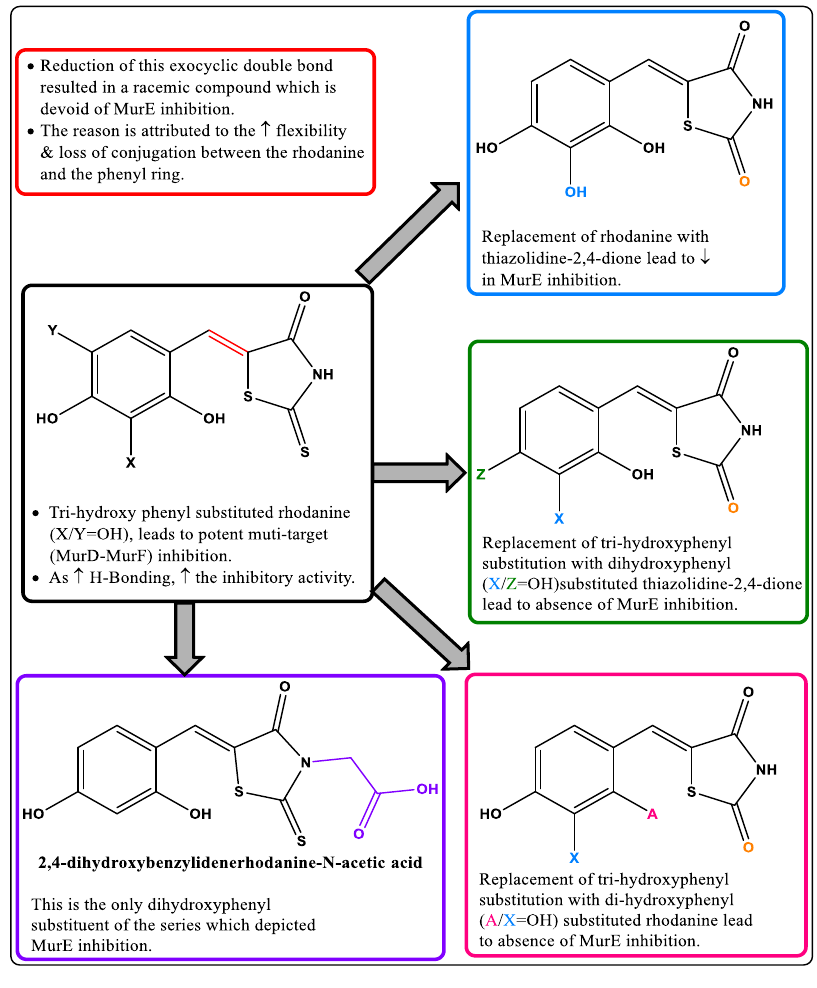
Figure 9. Modifications of 5-benzylidenethiazolidine as Mur enzyme inhibitors.